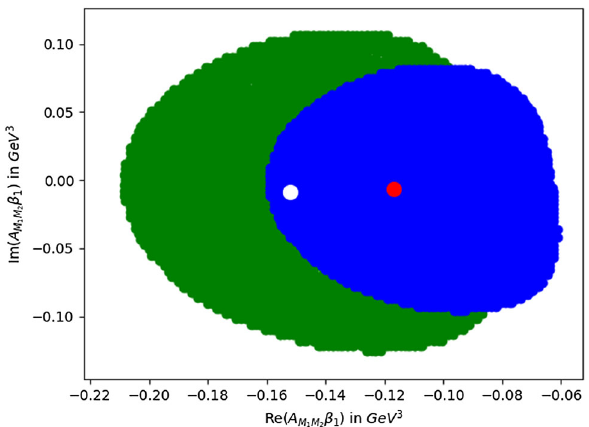
Fig. 7 Comparison of the SU ( 3 ) symmetric (blue, best fit point in red) and SU ( 3 ) breaking (green, best fit point in white) cases for the QCDF amplitude β